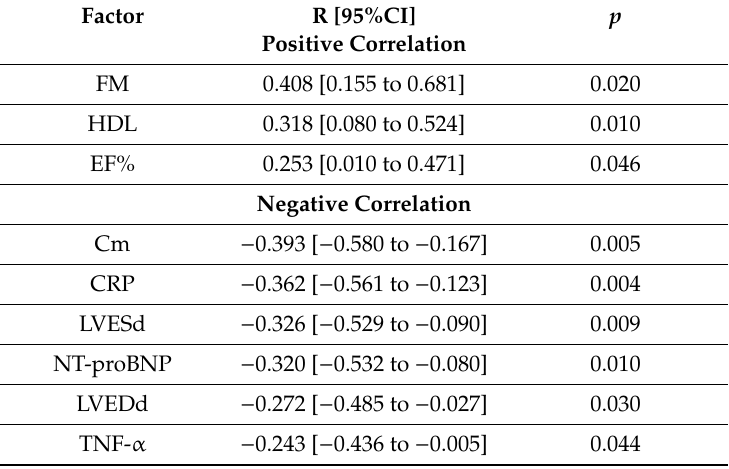
Table 3. Result of the correlation study—summary of the parameters significantly correlated